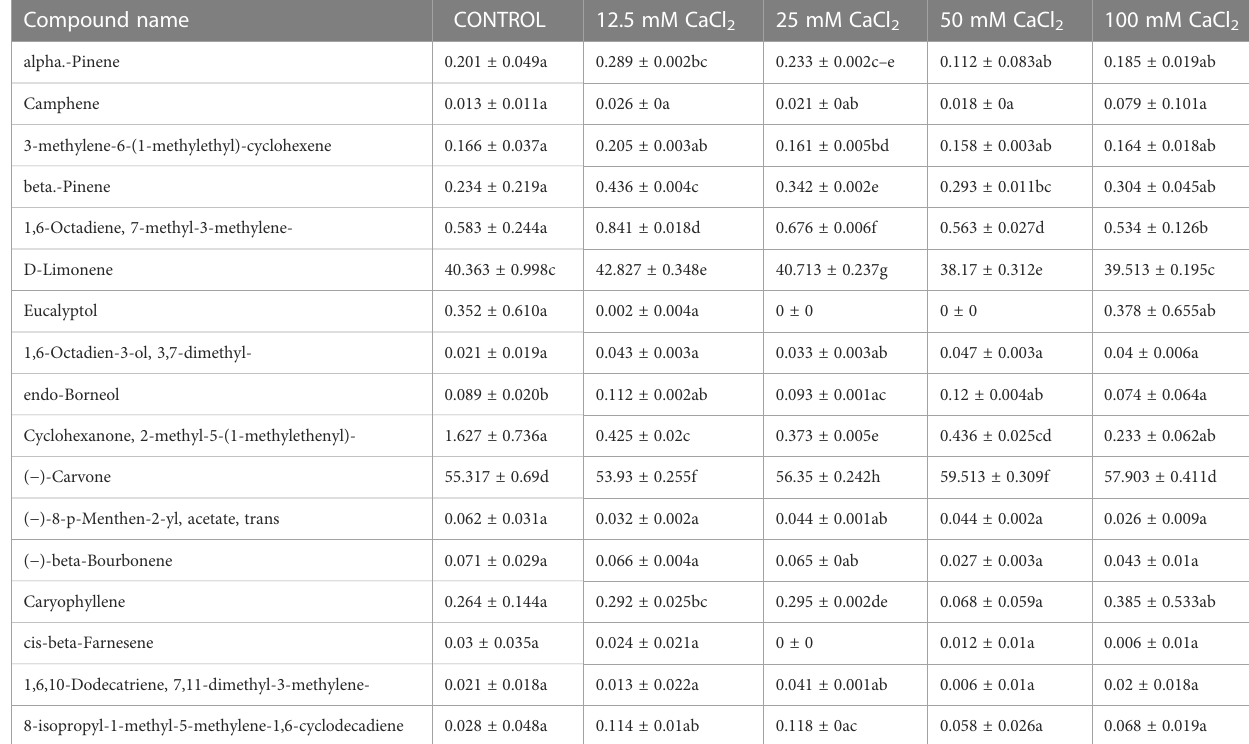
TABLE 7 Composition of essential oil under different CaCl 2 salt concentration treatments of M. longifolia fresh plant